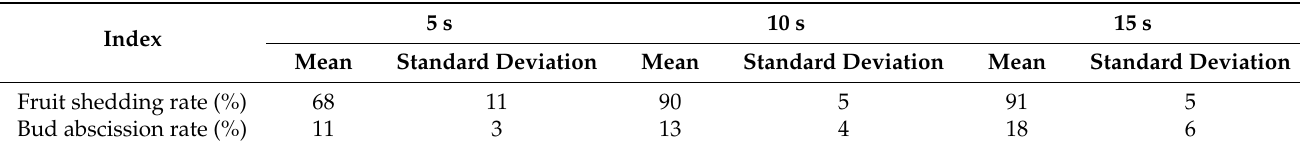
Table 5. Mechanized picking of camellia oleifera